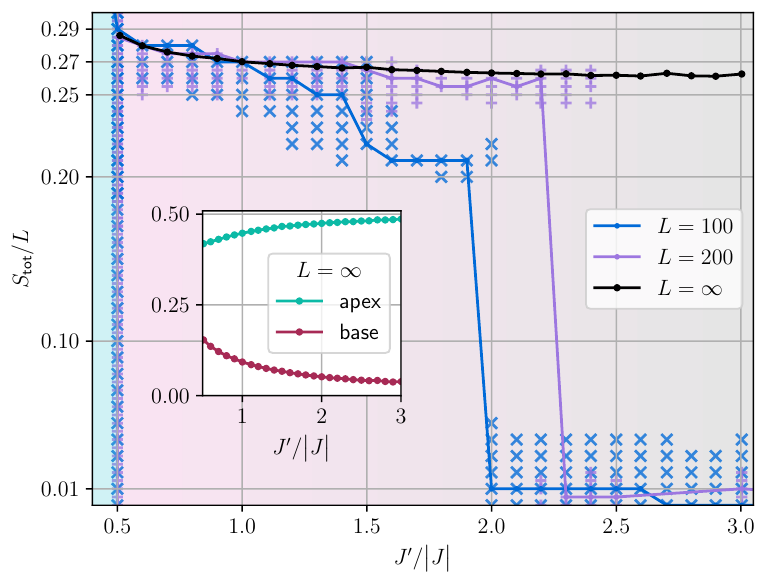
Figure 6: The same as Fig. 3, but including DMRG data obtained for the infinite system (VUMPS) without exploiting symmetries. In addition, the crosses indicate sectors of S in the finite system for which the energy density is within 10 − 3 of tot the ground-state energy density, illustrating the extreme shallowness of the energy minima (cf. Fig. 7). The inset shows the (translationally invariant) apical and basal (cid:199) (cid:10) (cid:11) 2 + (cid:10) (cid:11) 2 α α S x , S z , polarization ( α = A , B ) for L = ∞ i i